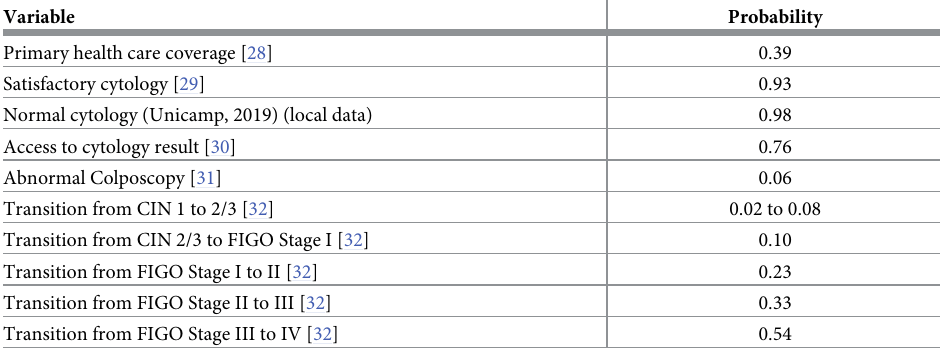
Table 1. Probabilities used by the model to compare screening strategies in Indaiatuba,